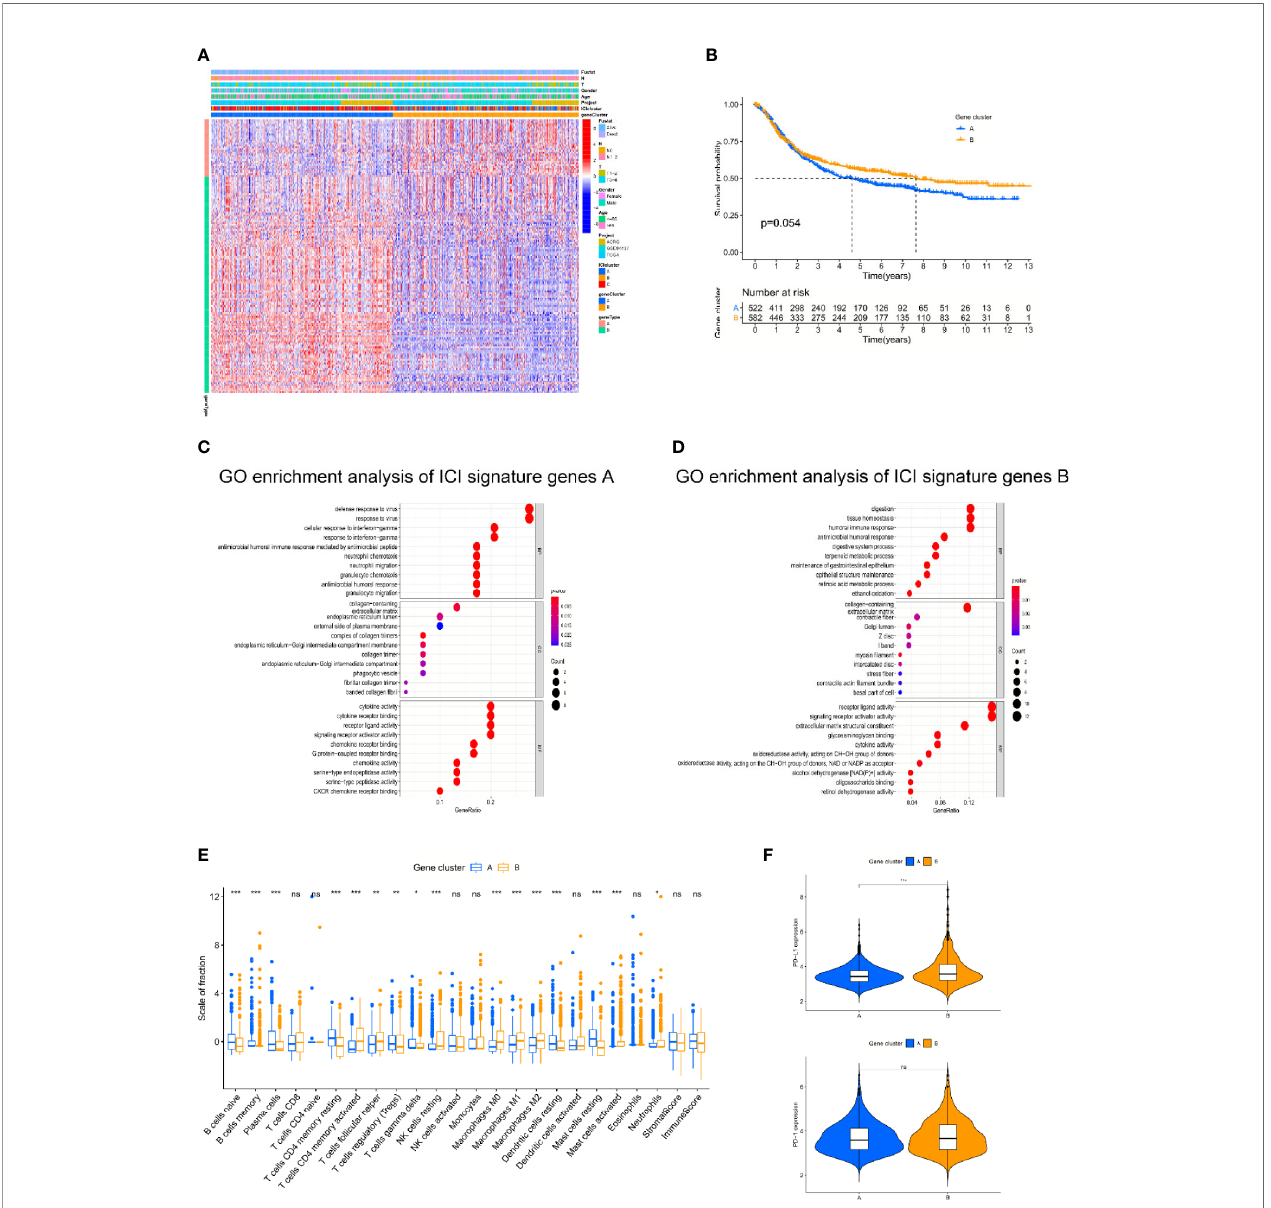
FIGURE 2 | The landscapes of immune related genes and subtype establishment. (A) Unsupervised clustering of differentially expressed genes derived from three ICI clusters helped divide patients into two groups, namely gene clusters A and gene clusters B. (B) The log rank test shown by Kaplan-Meier curves indicated an approaching statistical signi fi cance for overall survival comparison between two gene clusters. (p = 0.054). (C, D) Comparison of Gene Ontology (GO) enrichment analysis between the two ICI-relevant signature genes. (E) The fraction variations of tumor-in fi ltrating immune cells in two gene clusters. Immune score and stromal score of two gene clusters based on the ESTIMATE algorithm were also compared. (Kruskal-Wallis test. *p < 0.05; **p < 0.01; ***p < 0.001; ns, not signi fi cantly different). (F) Expression variations of PD-L1 and PD1 among different gene cohorts (Kruskal-Wallis test, *p < 0.05; **p < 0.01; ***p < 0.001; ns, not signi fi cantly